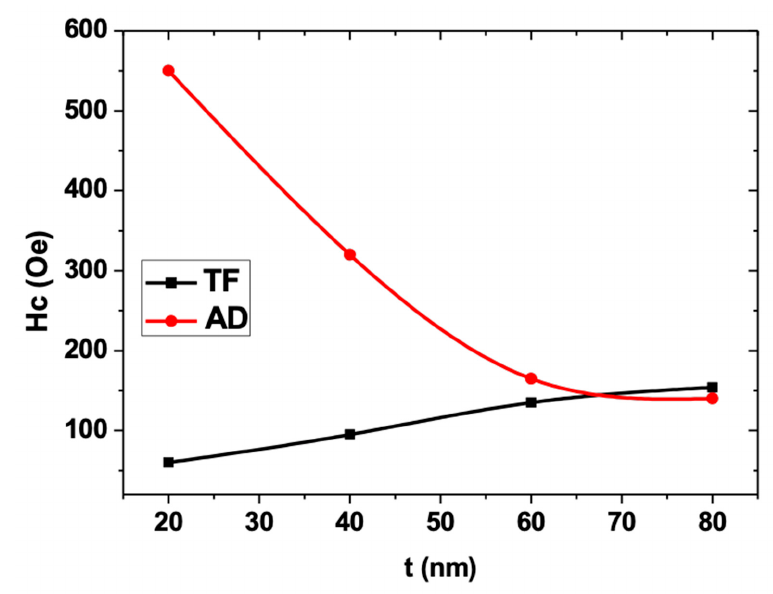
Figure 4. Room-temperature in-plane coercivity of the Fe 70 Pd 30 antidot arrays and their corresponding continuous thin films as a function of layer thickness.